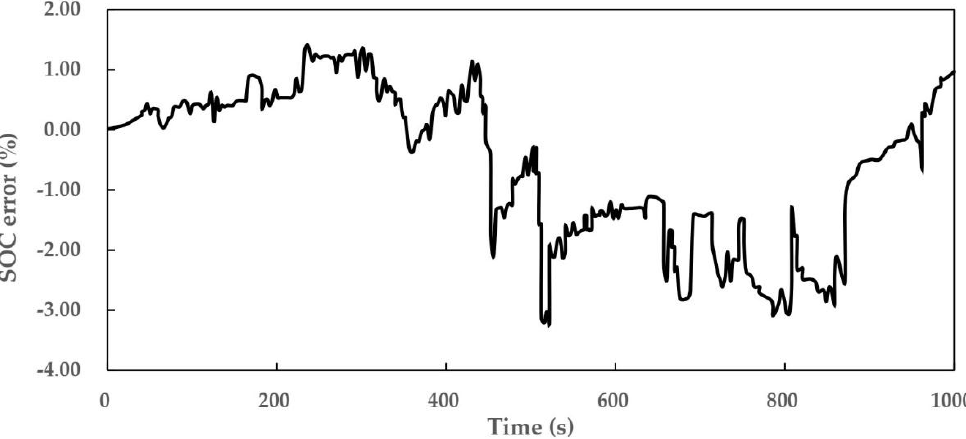
Appl. Sci. 2019 , 9 , x FOR PEER REVIEW Figure 7. DifferencebetweentheSOCestimatedvalueandtheactualvalueunderBBDSTworkingconditions. Figure 7 ． Difference between the SOC estimated value and the actual value under BBDST working conditions.